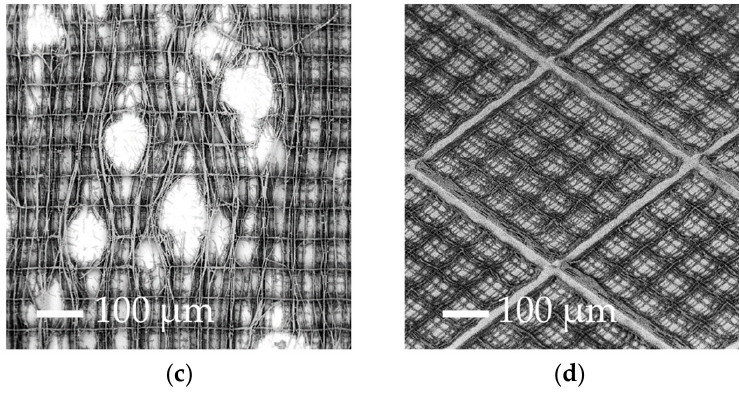
Figure 2. SEM images of the micro-fabrication before the optimization. Instability and deformation on ( a ) three elementary nichoids; ( b ) on the substrate composed of 367 elementary nichoids; ( c ) Collapse of the culture substrate covered with continuously-packed nichoids (CPN), more likely due to cavitation phenomena and vibration during the manufacturing process; ( d ) Instability issues in the culture substrate covered with a fractionated supermatrix of nichoids (FSN), including 218 matrixes at a distance of 30 μ m.